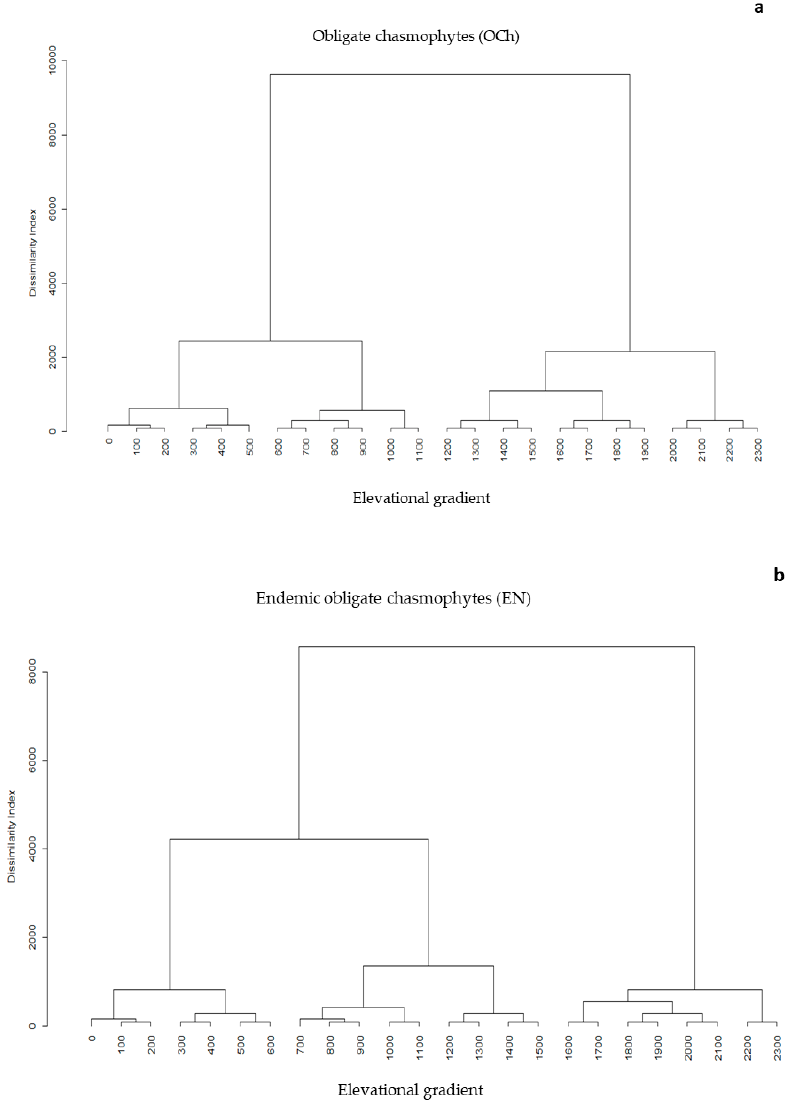
Figure 10. Hierarchical cluster analysis showing floristic similarity of the different elevational gradients of ( a ) obligate (OCh) and ( b ) endemic obligate (EN) chasmophytes. Sørensen index and the Wards criterion have been used for the similarity coefficient and the combination criterion, respectively.